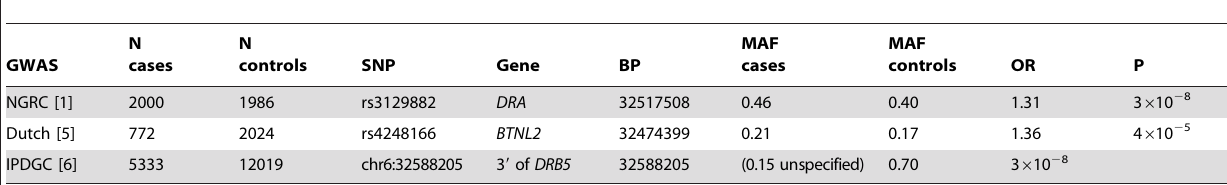
Table 1. HLA SNPs that have shown the most significant associations with PD in three GWAS’s.